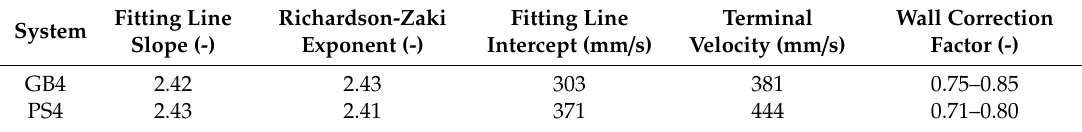
Table 2. Slope and intercept parameters of the fitting lines for the expansion of solids GB4 (Figure 4a) and PS4 (Figure 4b). Correlations for the Richardson–Zaki exponent, terminal velocity and wall correction factor, see Equation (15), are reported in Epstein [6] (Chapter 26).